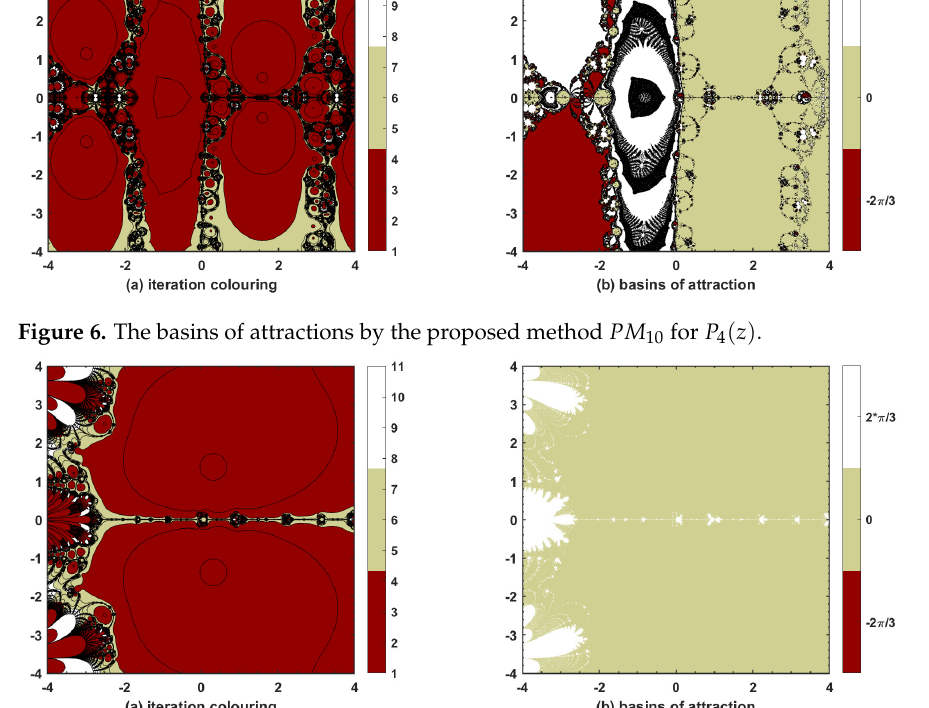
Figure 7. The basins of attractions by the proposed method PM 10 for P 5 ( z ) .